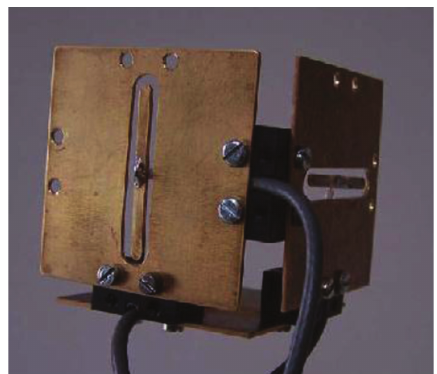
Figure 7: MIMO cube with slot dipoles on separated planes.